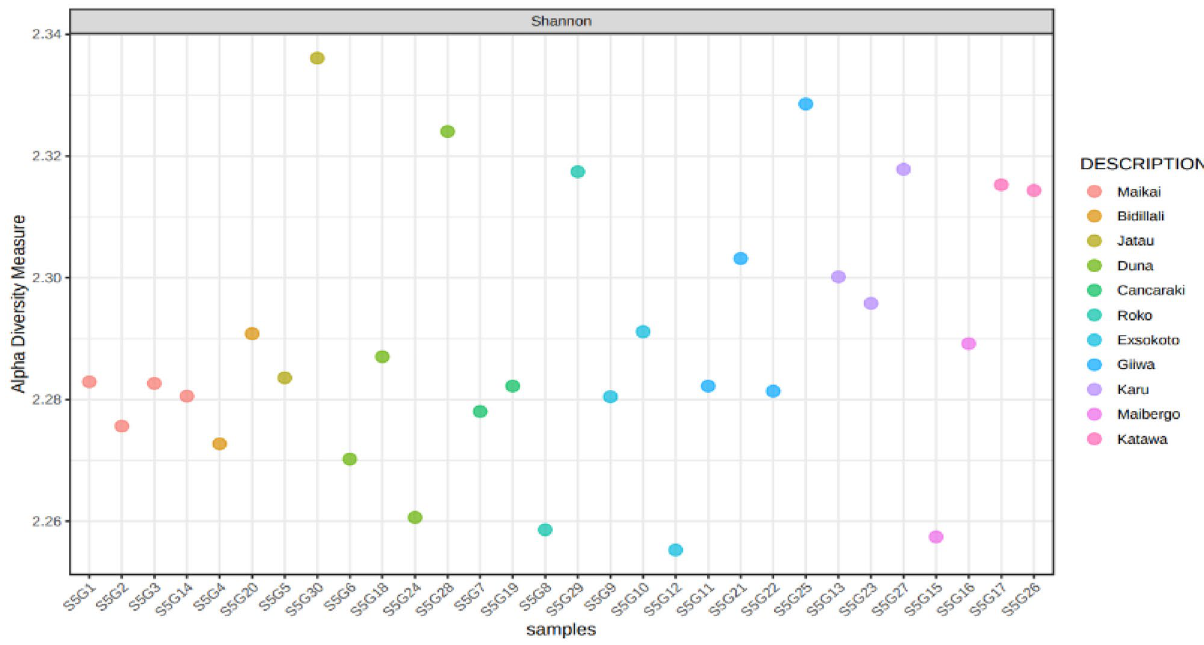
Figure 3. Estimation of Shannon-diversity of 30 evaluated accessions. In the figure right side legend (description indicated the 11 population of Bambara groundnut from which the 30 accessions were sampled. Samples are Duna (S5G6, S5G18, S5G24, S5G28); Maikai (S5G1, S5G2, S5G3, S5G14); Cancaraki (S5G7, S5G19); Roko (S5G8, S5G29); Bidillali (S5G4, S5G20); Jatau (S5G5, S5G30); Maibergo (S5G15, S5G16); Katawa (S5G17, S5G26); Giiwa (S5G11, S5G21, S5G22, S5G25); Karu (S5G13, S5G23, S5G27); and Exsokoto (S5G9, S5G10,